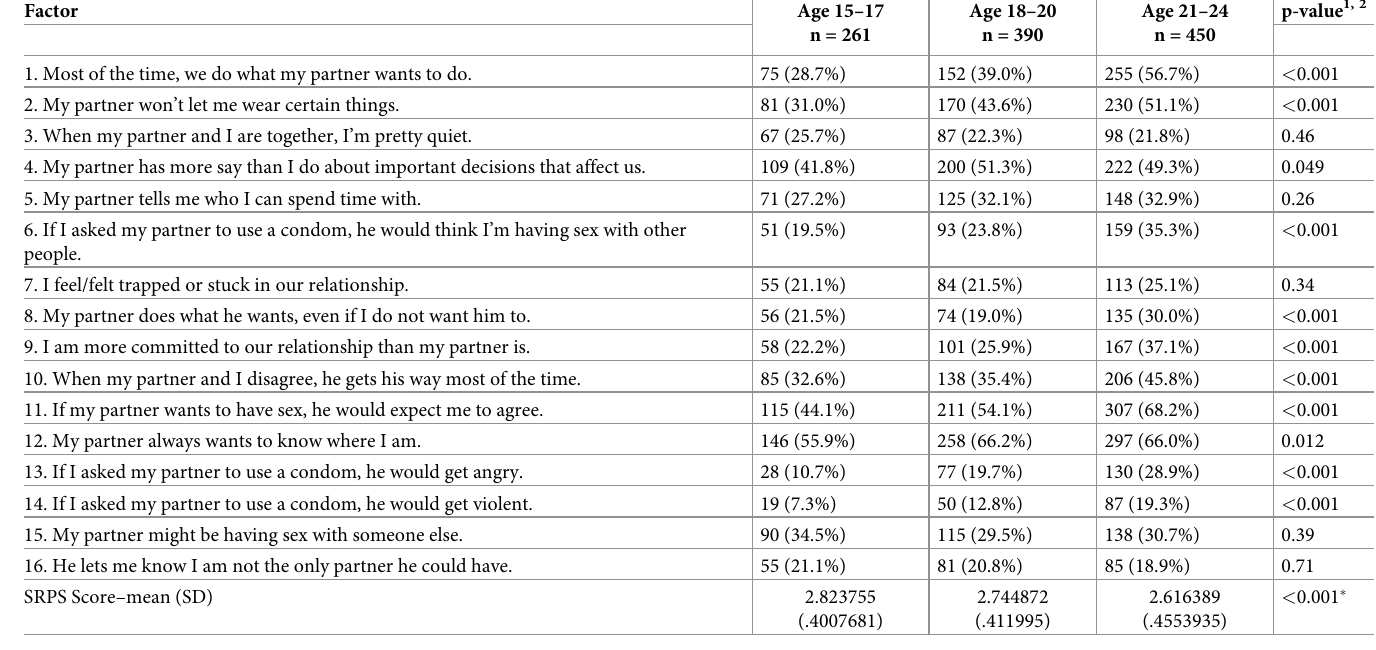
Table 2. Percent of AGYW who agree / strongly agree with individual items measuring power in sexual relationships via the Sexual Relationship Power Scale (SRPS), and mean scale scores (N = 1,101).